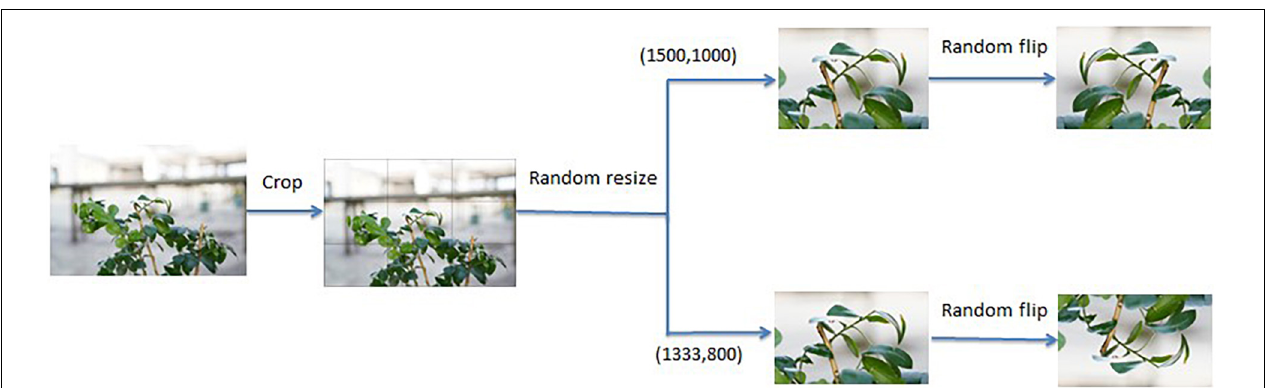
FIGURE 5 | Image cropping